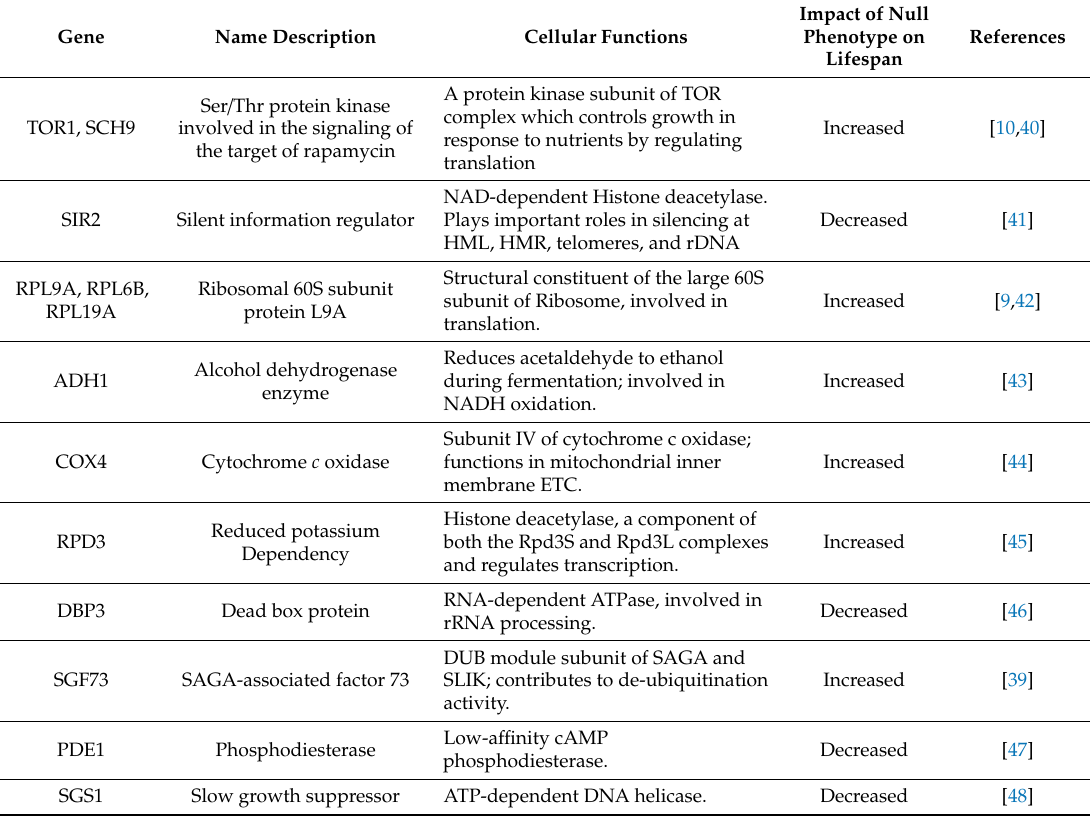
Table 1. List of some aging-associated genes in yeast and their cellular